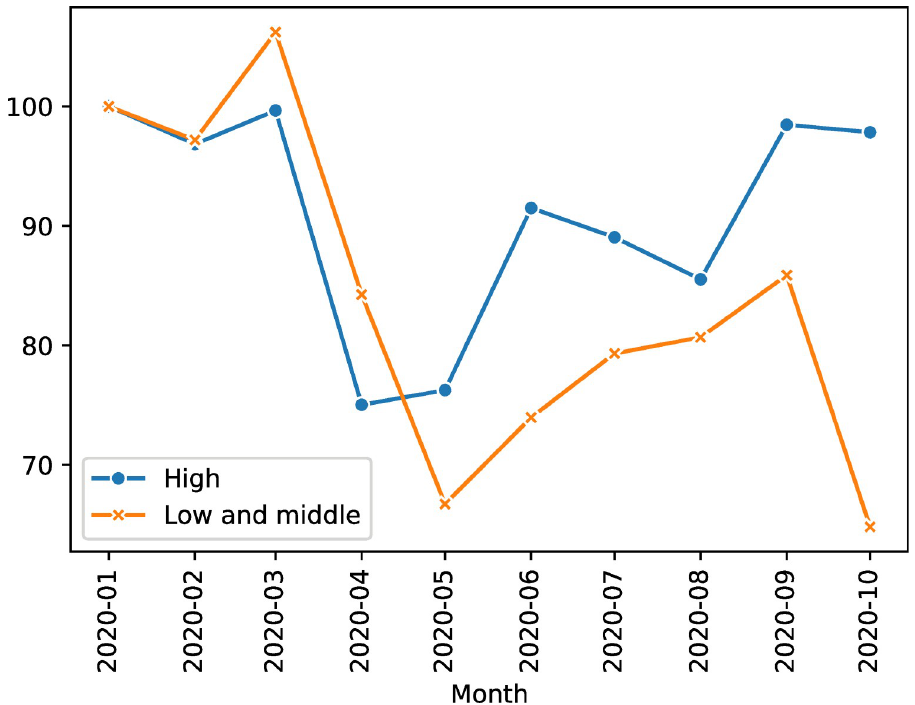
Fig 2. Monthly evolution index of total exports in 2020, relative to January 2020 = 100. Source: own elaboration using UN Comtrade trade data.